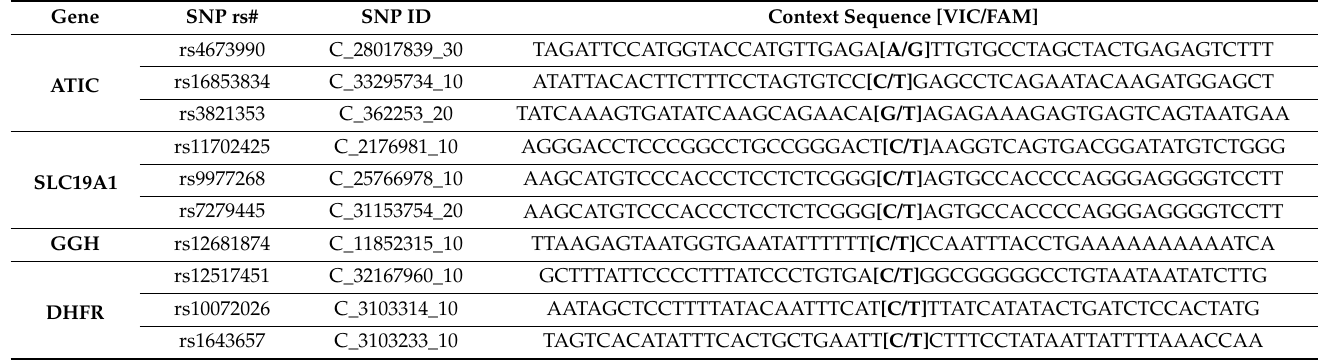
Table 2. TaqMan SNP genotyping assay details included in the